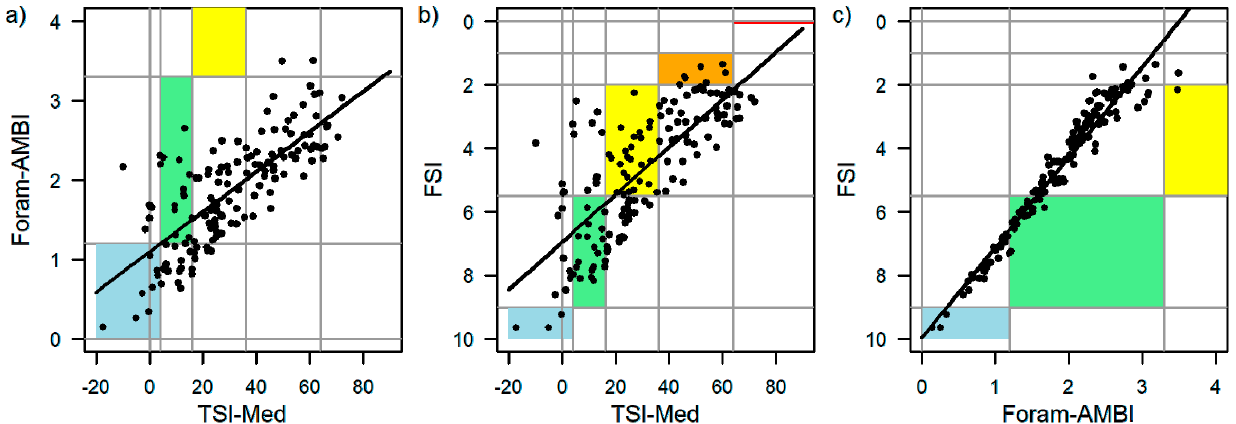
Figure 4. Quality indices based on homogenised groups of indicator species (i.e., Foram-AMBI assignment, [21]) compared two by two. ( a ) Foram-AMBI vs. TSI-Med, ( b ) FSI vs. TSI-Med, ( c ) FSI vs. Foram-AMBI. Information on linear regressions is summarised in Table 4. The grey horizontal and vertical lines represent the Ecological Quality Status limits presented in Table 1. Coloured rectangles correspond to the areas were both indices have the same EQS: blue, “very good”; green, “good”; yellow, “moderate”; orange, “poor” and red, “bad”. The scale for FSI is reverse so that the environmental qual-ity scale is in the same direction for each